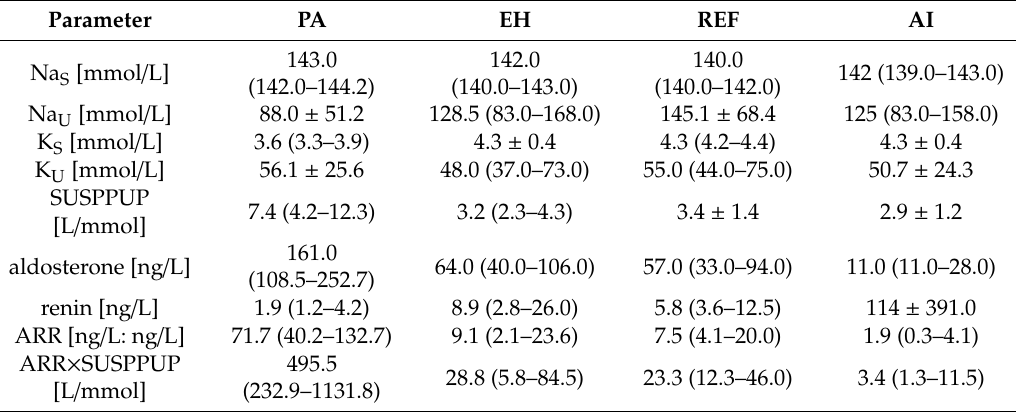
Table 2. Laboratory results.